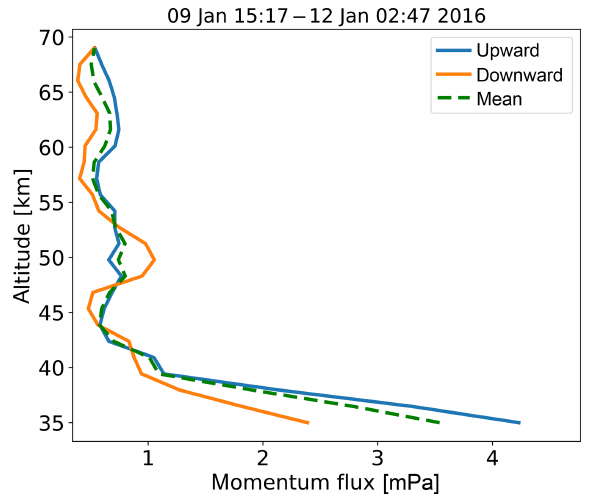
Figure 18. Vertical flux of horizontal momentum averaged through all observed hodographs (dashed) and upward-propagating (blue) and downward-propagating (orange) waves.